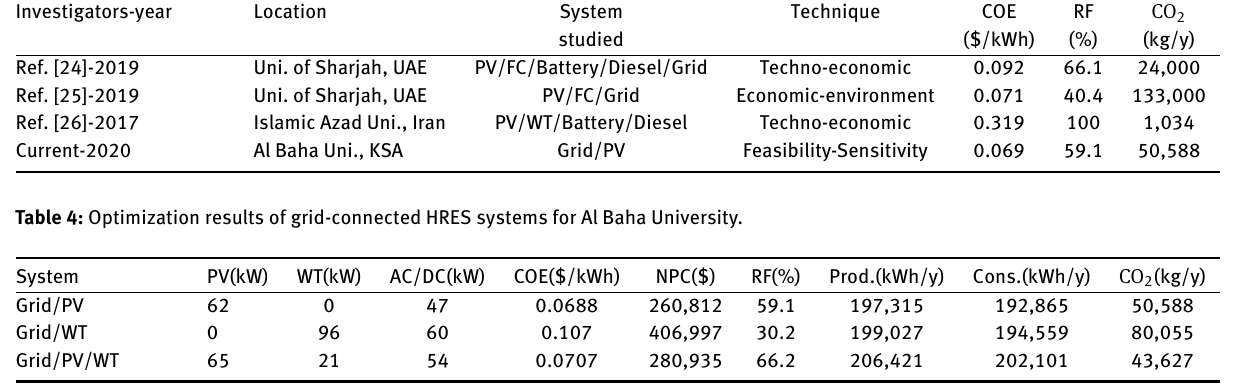
Table 3: Brief comparison of related studies.